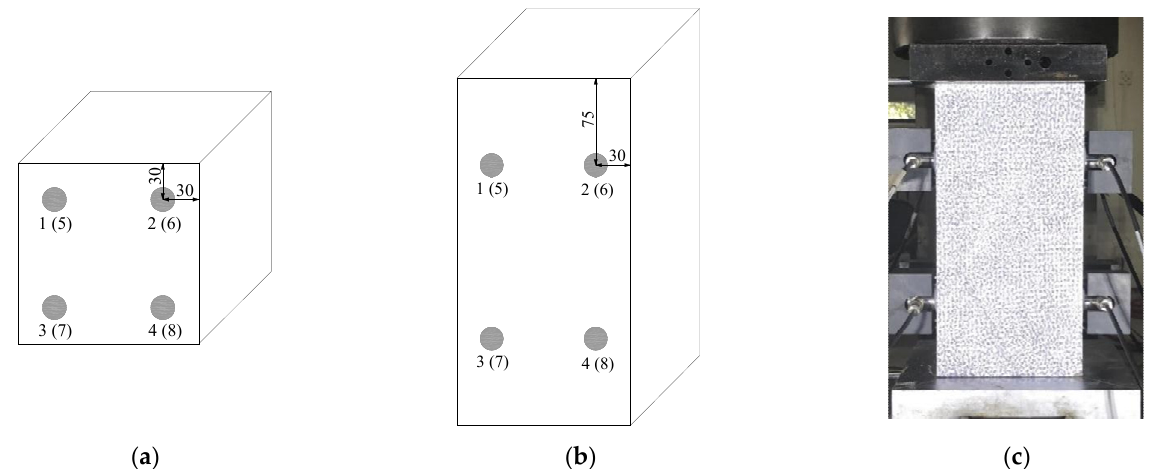
Table 2. The setting value of acoustic emission (AE) parameters.